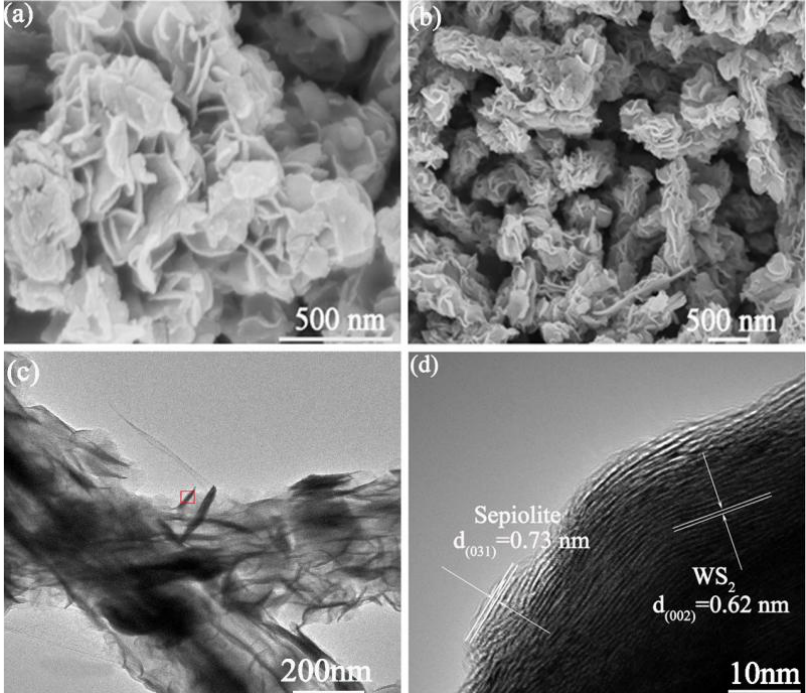
Figure 2. Morphology and structure of the pure WS 2 and WS 2 /sepiolite nanocomposite. ( a , b ) SEM images of the pure WS 2 and WS 2 /sepiolite nanocomposite obtained via solvothermal; ( c , d ) TEM and HRTEM images of WS 2 /Sep.